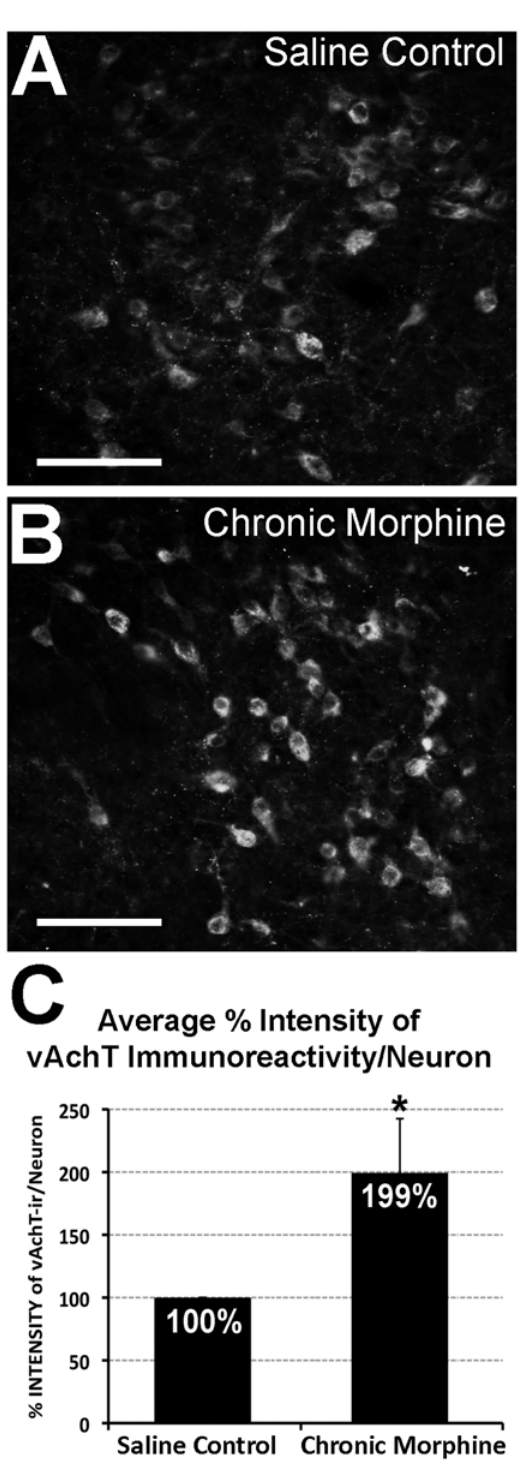
Fig 2. Cholinergic Neurons of the Laterodorsal Tegmental Nucleus in the Ventrolateral Periaqueductal Gray. Photomicrographs illustrate vesicular acetylcholine transporter (vAChT) immunofluorescence in the laterodorsal tegmental nucleus. Cholinergic neurons are labeled more intensely following chronic morphine treatment (B) in comparison to saline control group (A) . Graph in Panel C illustrates average percentage (%) intensity of vAChT immunoreactivity per individual cholinergic neuron